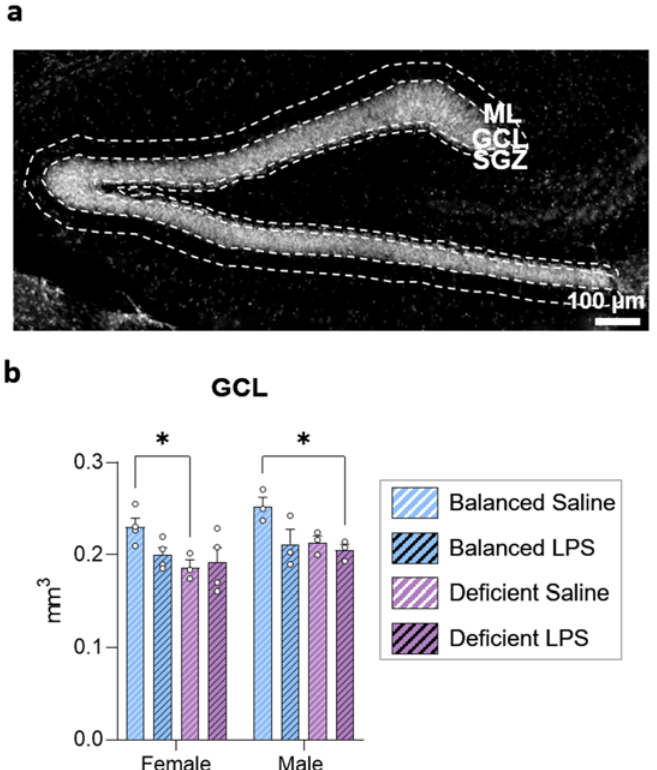
Figure 2. The n ‐ 3 PUFA deficient diet reduced the volume of the granule cell layer (GCL). ( a ) Epifluorescence image of the dentate gyrus showing the limits of the different layers (dotted lines): subgranular zone (SGZ), GCL, and molecular layer (ML). Images from each animal group are available in Supplementary Figure S1. ( b ) We observed a significant reduction in the volume of the GCL of female mice treated with saline and fed with the n ‐ 3 PUFA ‐ deficient diet compared to female mice fed with the balanced diet and the same treatment. Additionally, we detected a significant reduction in the volume of the GCL of male mice treated with LPS and fed with the n ‐ 3 PUFA ‐ deficient diet compared to male mice fed with the balanced diet and treated with saline. * p < 0.05 (statistics de ‐ tailed in Supplementary Data).